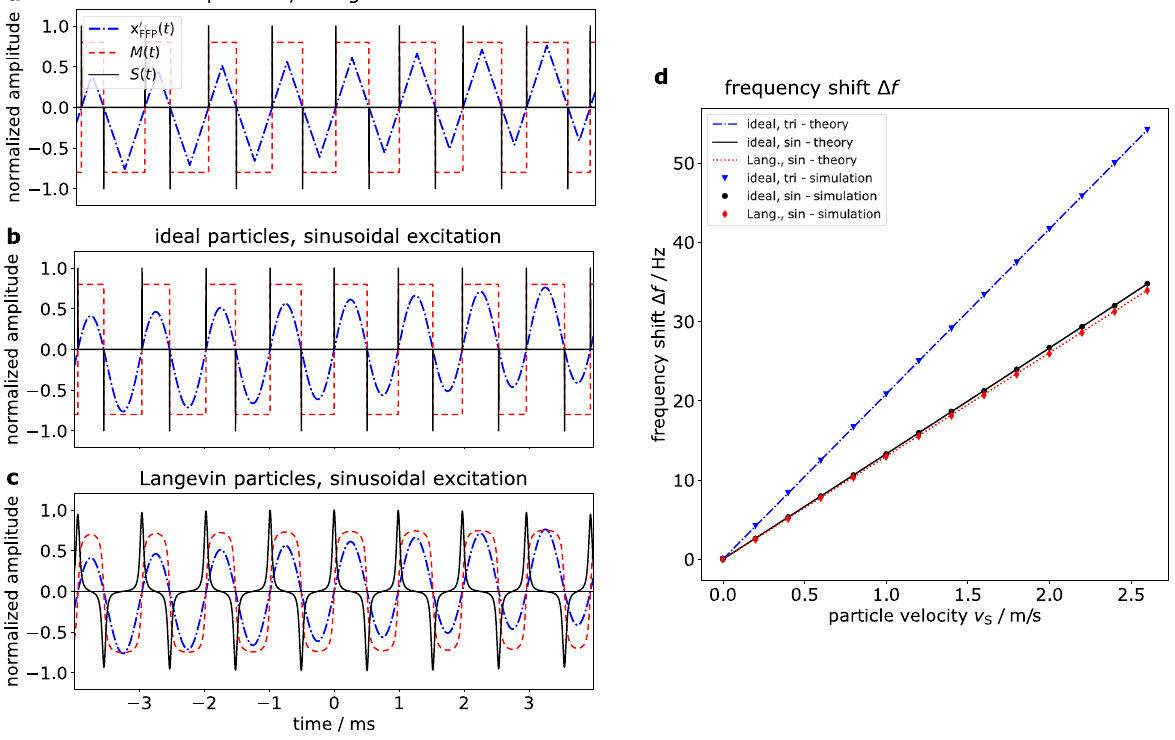
Figure 3. Signal trajectories for moving particles and frequency shift against particle velocity for different particle types and excitation waveforms. Simulations of the FFP trajectory x ′ FFP ( t ) , the particles’ magnetization M ( t ) and the signal S ( t ) are shown for three different cases: ( a ) Ideal particles and triangular excitation, ( b ) ideal particles and sinusoidal excitation, ( c ) Langevin particles ( m 0 = 3.35 · 10 − 18 Am 2 , T = 293 K) and sinusoidal excitation. The trajectories are shown for moving particles at 1.5 m/s. The signal, magnetization and FFP trajectory were normalized to 1, 0.8 and 0.5, respectively, with the purpose to better distinguish between the curves. The drive field frequency was exemplarily set to 1 kHz. In case of ideal particles, the delta peaks in the signal appear during zero crossings of the FFP trajectory. ( d ) Shift of the signal’s fundamental frequency (cid:31) f over the particles’ velocity v s for three different cases derived theoretically and based on simulation: Ideal particles and triangular excitation (blue, dashdotted line; triangles), ideal particles and sinusoidal excitation (black, solid line; dots), Langevin particles ( m 0 = 3.35 · 10 − 18 Am 2 , T = 293 K) and sinusoidal excitation (red, dotted line; diamonds). The amplitude of the FFP trajectory is x max FFP = 12